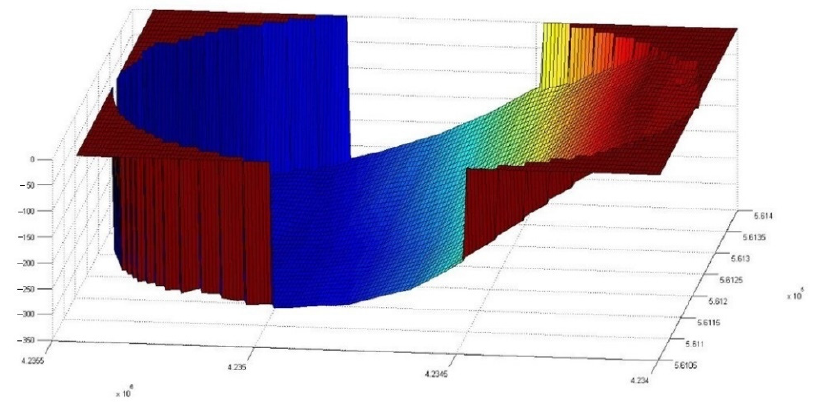
Figure 15. Three-dimensional plane view of the ellipsoidal bathymetric subdomain.